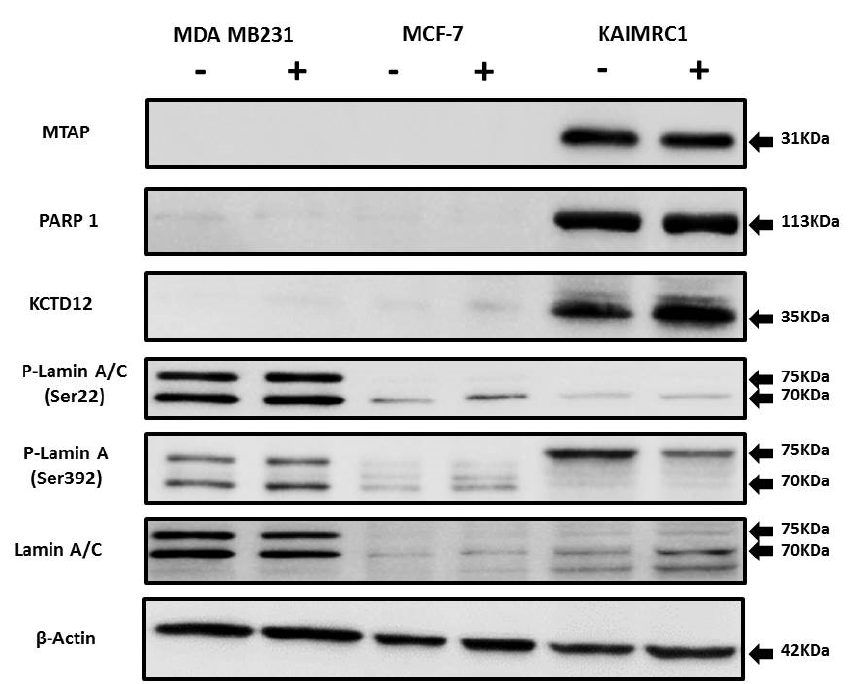
Figure 5. Expression of MTAP, PARP1, KCTD12, and Lamin A / C in cancer cell lines: Western blot analysis of protein expression of MTAP, PARP1, KCTD12, Lamin A / C, and phosphorylated Lamin A / C in MDA MB231, MCF-7, and KAIMRC1 cells. Preparation of cell lysates and western blot were performed as described under the Materials and Methods section. In both normal ( + ) and serum-starved (-) conditions, KAIMRC1 cells showed strong expression of MTAP, PARP1, and KCTD12 compared to MDA-MB231 and MCF-7 cells. Moreover, KAIMRC1 cells showed weak expression of Lamin A / C and phosphorylated Lamin A / C in comparison to MDA MB231 cells, thus validating our proteomics results.